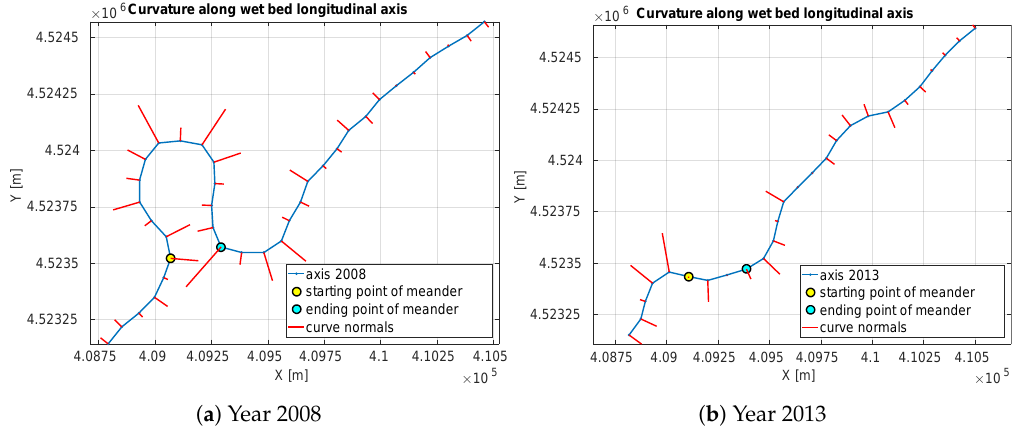
Figure 9. Curvature weighted normal lines to the wet river channel axis. Seman river, 2008 and 2013. Table 7. Cartesian ( · cx ) and axial ( · ax ) lengths ( L ), sinuosity index ( I ) of active ( · ab ) and wet ( · wb ) channels, extracted from the elaboration of the Vjosë River LANDSAT imagery, time period 1972–2017.